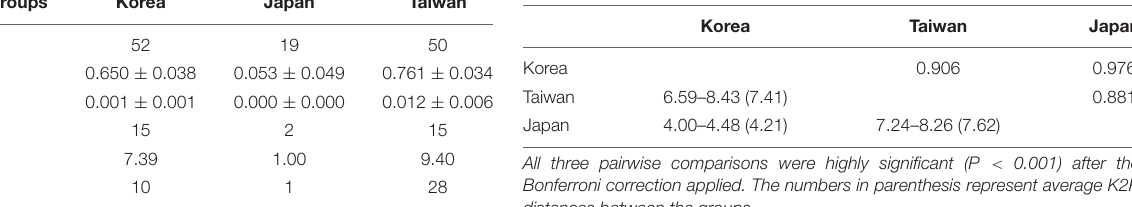
TABLE 2 | Pairwise genetic differentiation ( F ST ) based on haplotypes (above diagonal) and Kimura-2-parameter (K2P) distances (%) among the three phylogenetic groups (below diagonal) in Alveopora japonica using the ITS